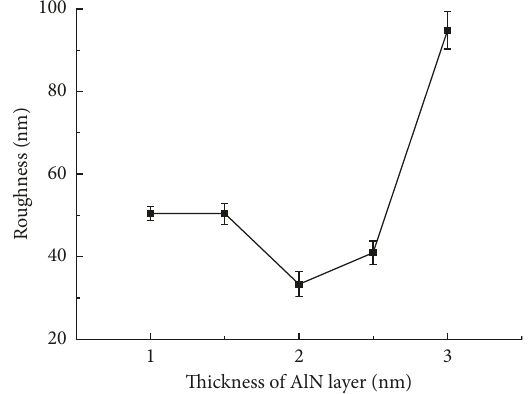
Figure 4: Surface roughness of TiSiN/AlN nanomultilayers with different thicknesses of AlN layer.